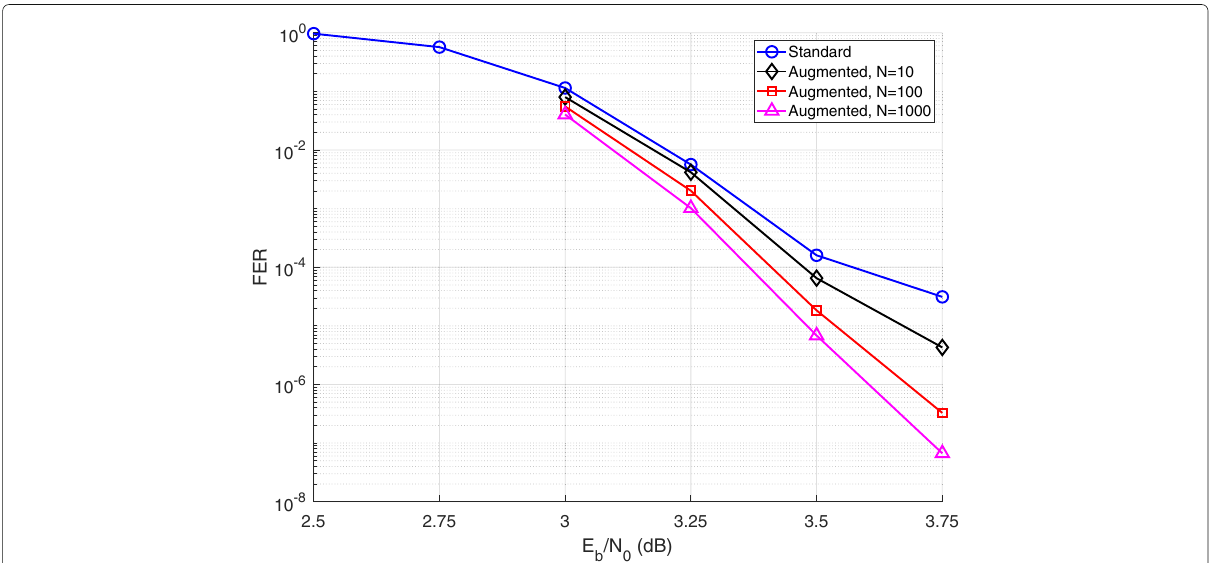
Fig. 3 Quasi-regular FER plot. FER performance of augmented decoders for the n = 4095, R = 0.82 quasi-regular code